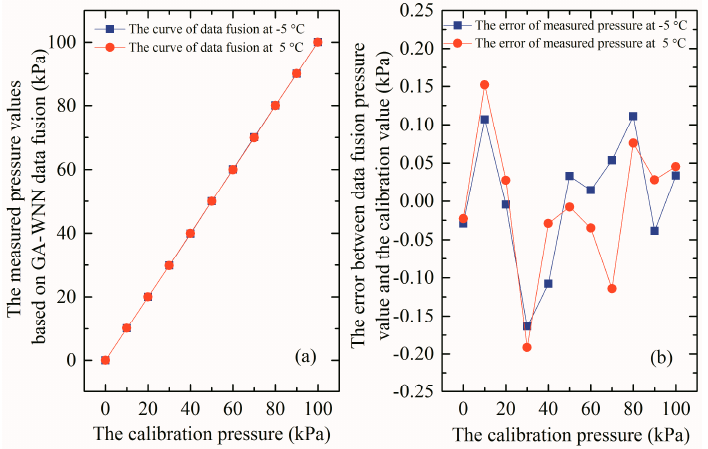
Figure 18. ( a ) The relationship curves between the corrected pressures of array-type sensor and the calibration pressures at different temperature; and ( b ) the absolute error between the corrected pressures of array-type sensor and the calibration pressures at different temperature.